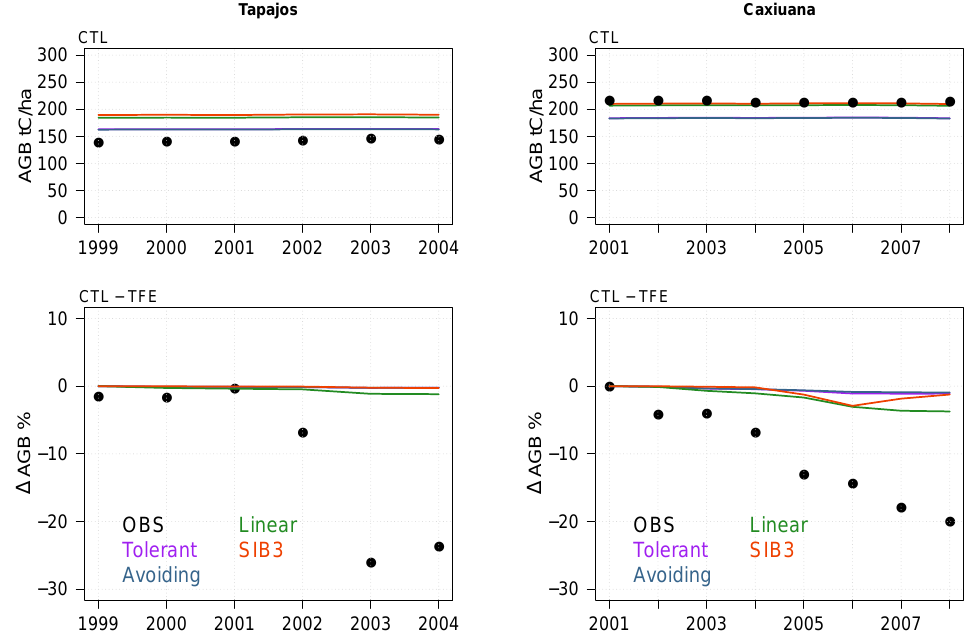
Figure 10. Times series of the yearly above-ground biomass (AGB) for the control plot (top) and the difference between the exclusion and control plot (bottom) at Tapajós (left) and Caxiuanã (right).